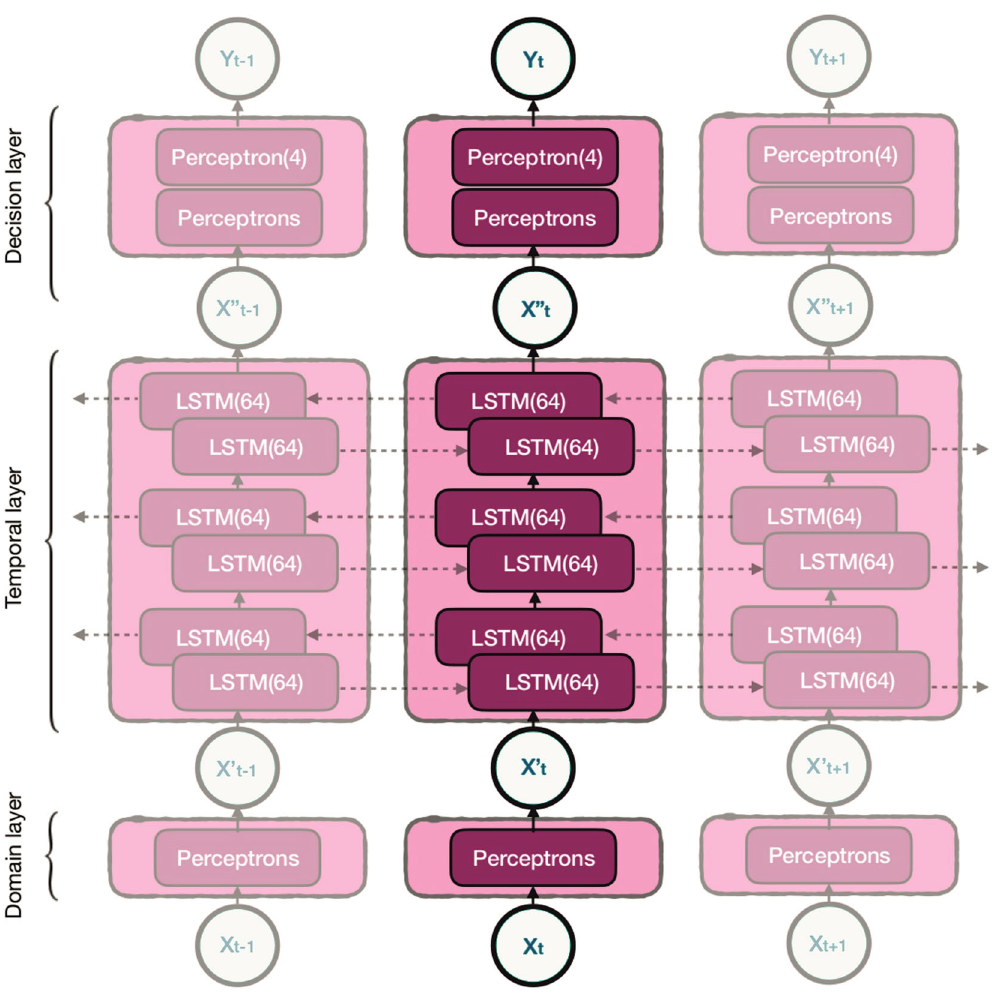
Fig. 7 A partially rolled-out overview of the neural network architecture to visualise the temporal interaction. The dotted arrows indicate the fl ow direction of temporal information through LSTM